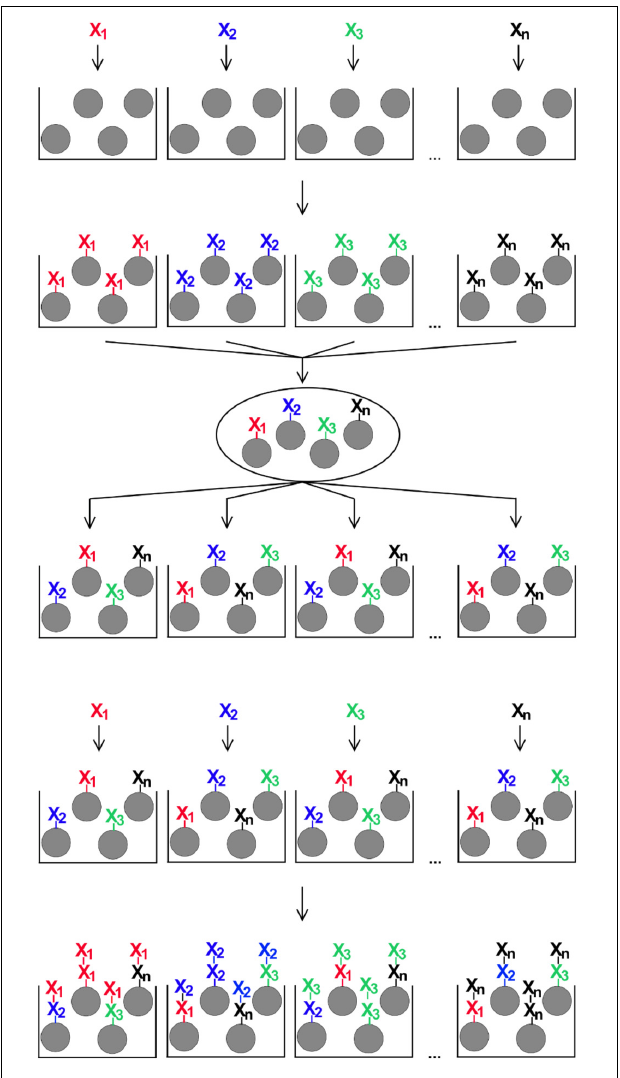
FIGURE 1 | Schematic illustration of the split-and-mix procedure for the generation of OBOC-libraries. For peptide libraries, each of n individual amino acids (X1 – Xn) is coupled to a portion of synthesis resin, then all beads are combined and mixed, distributed again in n portions, and the next coupling step with one individual amino acid per portion is performed. The number of repeated rounds of the procedure corresponds to the peptide length on each individual